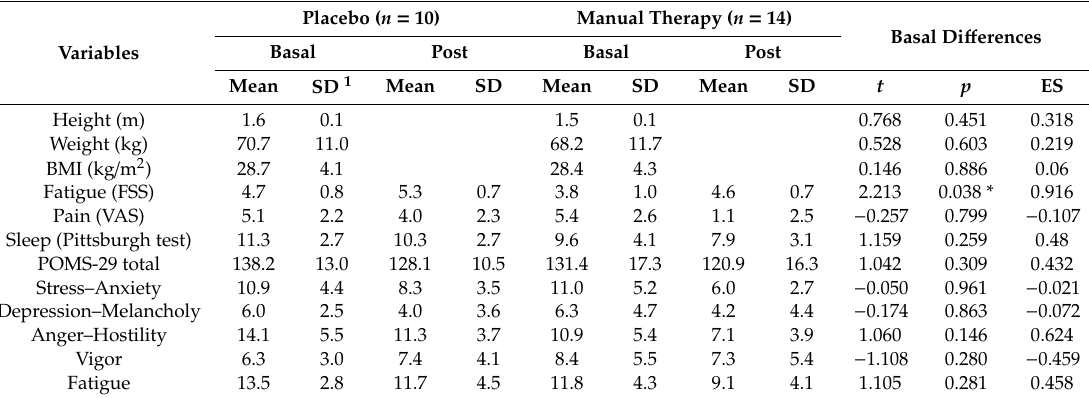
Table 1. Sample characteristics at baseline and post-intervention.